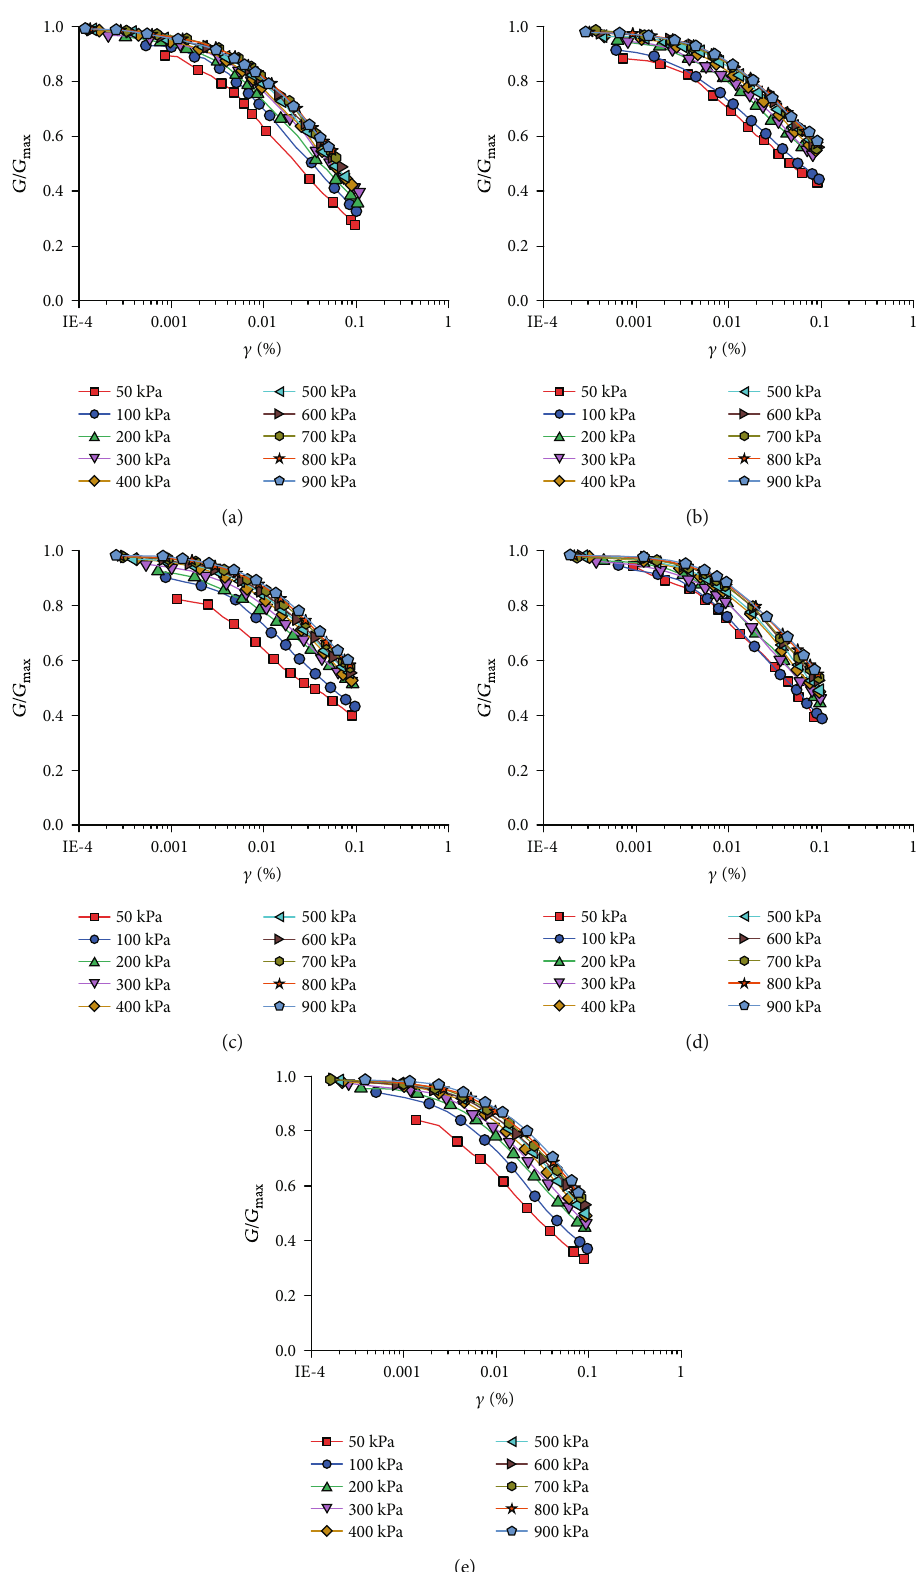
Þ − γ decay curves: (a) undisturbed HWG; (b) HWG R1; (c) HWG R2; (d) HWG R3; and (e) HWG Figure 10: Normalized sti ff ness ð G / G max R4. (Data points